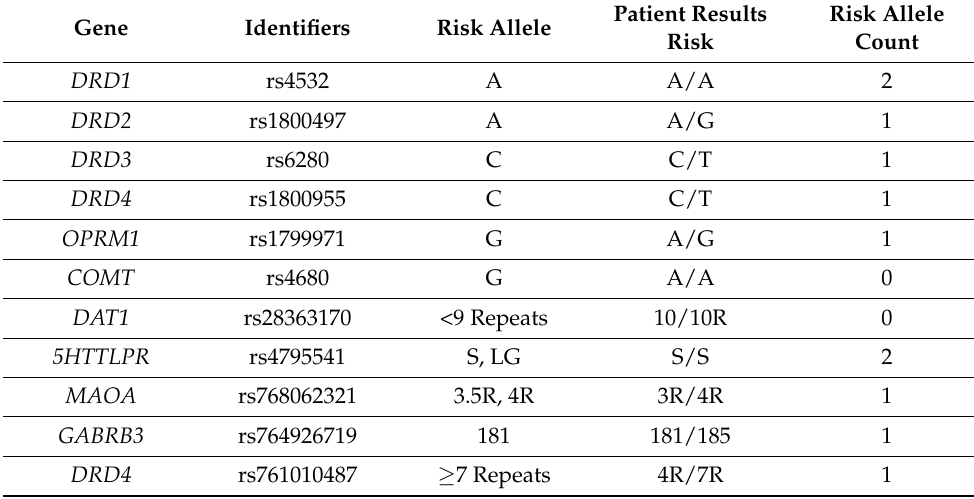
Table 12. Daughter’s GARS test results